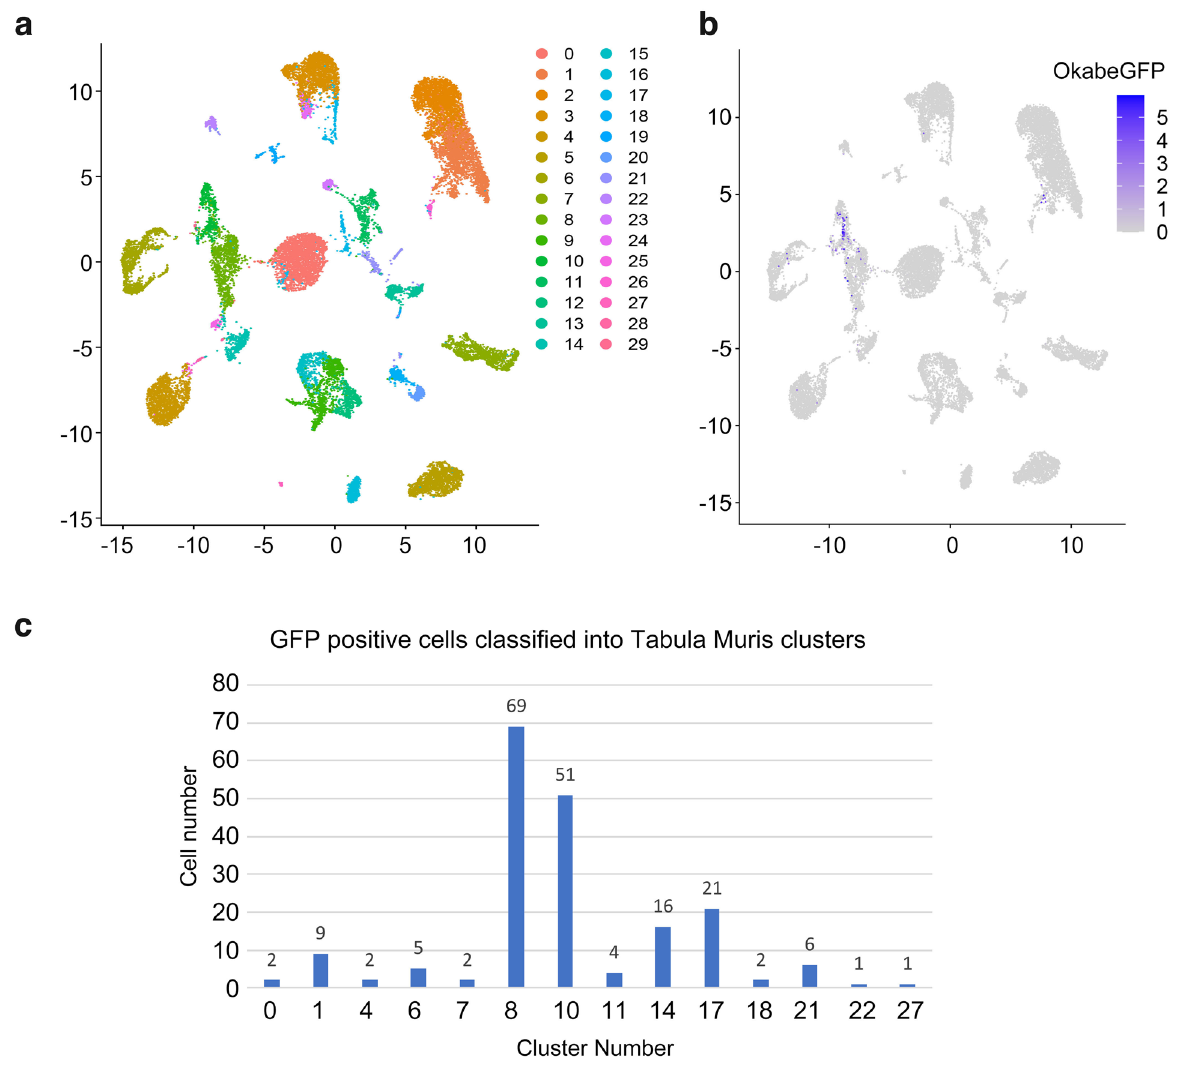
Figure 3. Mixed-clustering analysis of Tabula Muris data and isolated GFP-positive cells. ( a ) ScRNA-seq data of isolated cells (210 cells) was combined with Tabula Muris female data (representing 20,586 cells) and clustered by Seurat using a set of 11 principal components (see Methods). Thirty cell clusters were identified and the overall clustering pattern of the data was illustrated by using uniform manifold approximation and projection (UMAP). ( b ) In the figure, 191 Okabe GFP -expressing cells (as confirmed by scRNA-seq data; 19 of the isolated cells were GFP-negative) are shown as purple dots on the same UMAP plot as in ( a ). GFP-positive MMc cells were classified into multiple clusters, indicating that MMc cells represent multiple cell types. Gradation of GFP (0–5) indicates the expression of the Okabe GFP gene. ( c ) Bar plot representation of GFP-positive cells categorized into UMAP clusters. Majority of cells clustered into either cluster 8 (myeloid cell, 69 cells) or cluster 10 (granulocyte, 51 cells). R (https:// cran.r- proje ct. org, ver.3.6.1) with Seura package (ver. 4.0.4, https:// satij alab. org/ seurat/ artic les/ pbmc3k_ tutor ial. html), and Microsoft EXCEL (https:// www. micro soft. com, EXCEL for Mac ver. 16.62) were used to create the images and the that the frequency of MMc cells largely differs among inter-individual embryos 20 . However, the existence of inter-individual variations in MMc cell types remained to be clarified. Accordingly, in the current study, data for the MMc cells isolated from 26 embryos implied that the proportions of MMc cell types differ between individu- als (Fig. 4c; Supplementary Table 3). Since the potential role of MMc cells in the fetus and the neonate is often related to the immune system, such as immunological tolerance, with activation of cytotoxic profile upon deple- tion (Castellan et al . , submitted), we also analyzed the potential variation in the proportion of immune-related MMc cells (defined by clustering analysis with Tabula Muris data) in different embryos. We found statistically significant differences in the proportion of immune-related MMc cells among individual embryos (Table 3, p = 4.95 × 10 −6 , Fisher’s exact test, two-sided). Similarly, we detected a significant variation in the proportion of MMc proliferating/stem cells (Table 2, p = 0.0398, by Fisher’s exact test, two-sided). Taken together, these obser- vations suggest that the MMc cell type repertoire differs between embryos.